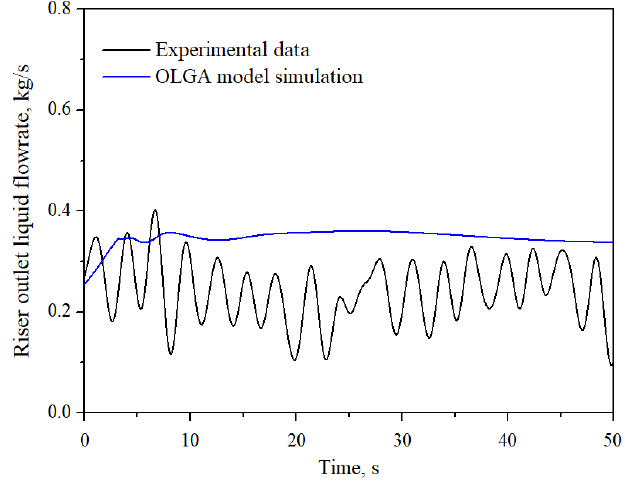
Figure 18. Experimental and simulated liquid production trends during choking-induced bubbly flow ( U GS = 0.08 m/s and U LS = 0.09 m/s). flow ( U GS = 0.08 m/s and U LS = 0.09 m/s).